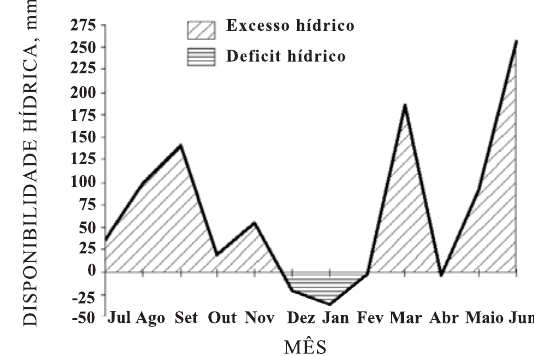
Figura 2. Balanço hídrico para capacidade de armazenamento de água na profundidade de solo (capacidade de armazenamento de 50 mm) segundo Thornthwaite & Mather (1955) no período de realização do experimento, Estação EEA/UFRGS,